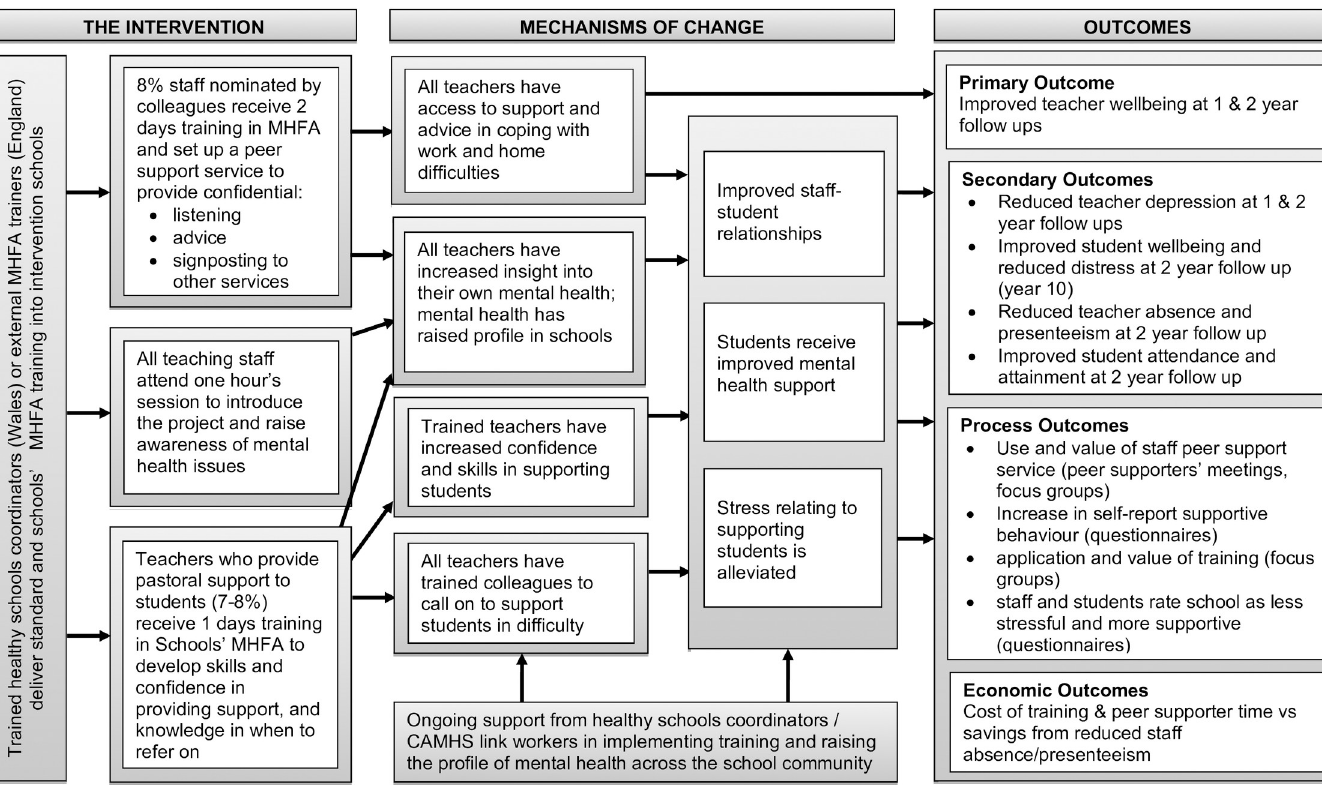
Fig 1. Logic model of the WISE intervention. CAMHS AU : AbbreviationlistshavebeencompiledforthoseusedinFigs 1 ; 2 ; and 4 : Pleaseverifythatallentriesarecorrect : , Child and Adolescent Mental Health Services; MHFA, Mental Health First Aid; WISE, Well-being in Secondary Education.